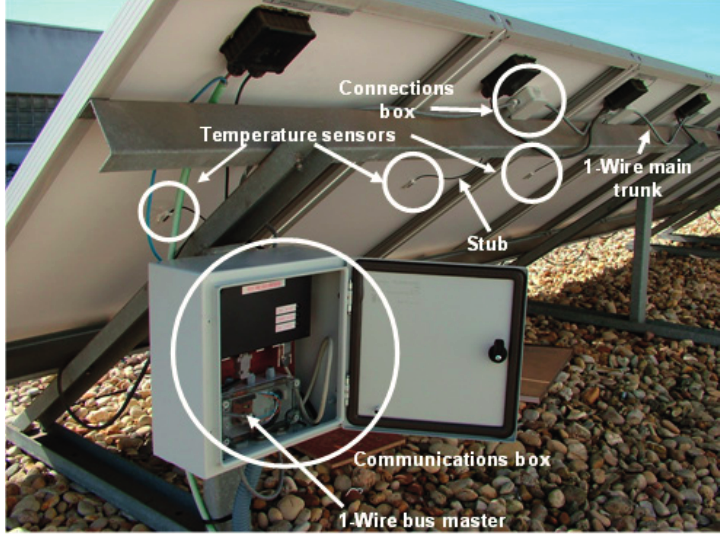
Figure 7. Rear panel installation with the instrumentation